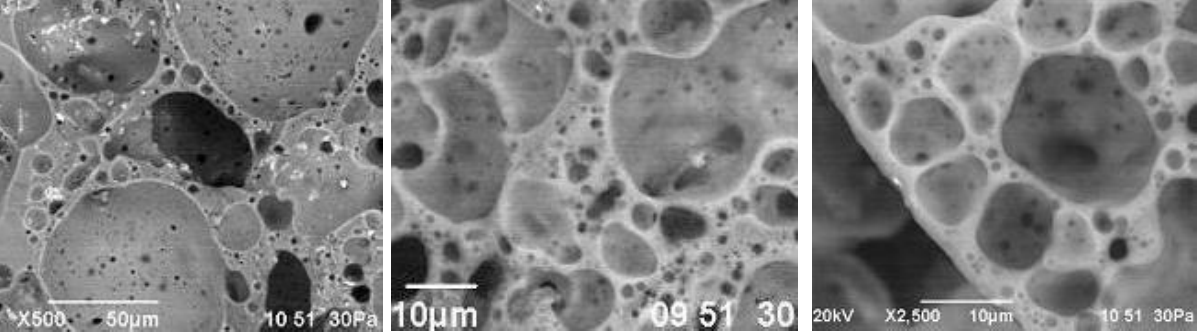
Figure 14. Microstructure of glass ‐ ceramic foam granules from raw mixture CB31.